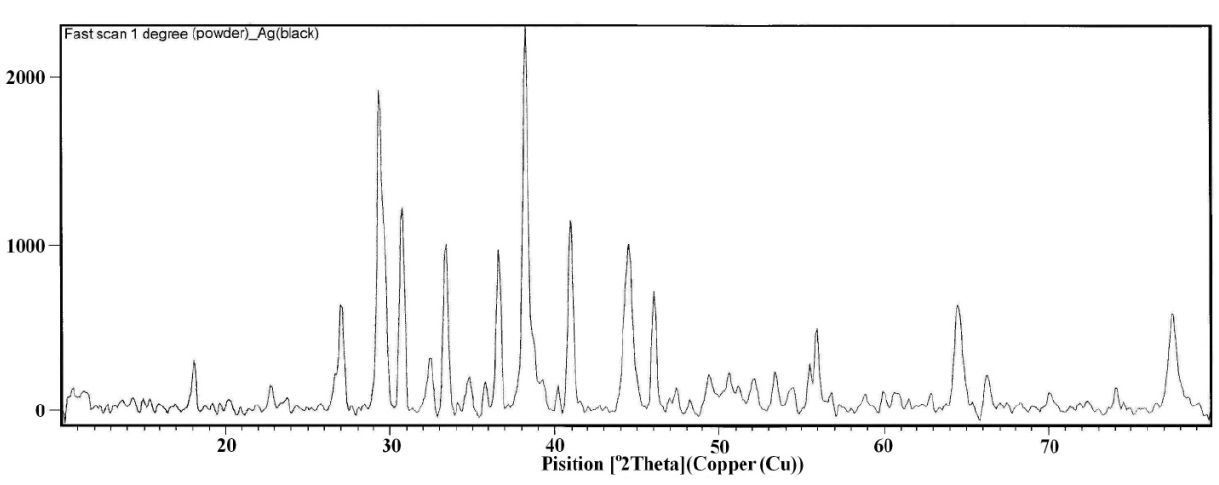
Figure 5. XRD pattern for synthesized silver oxide nanoparticles.